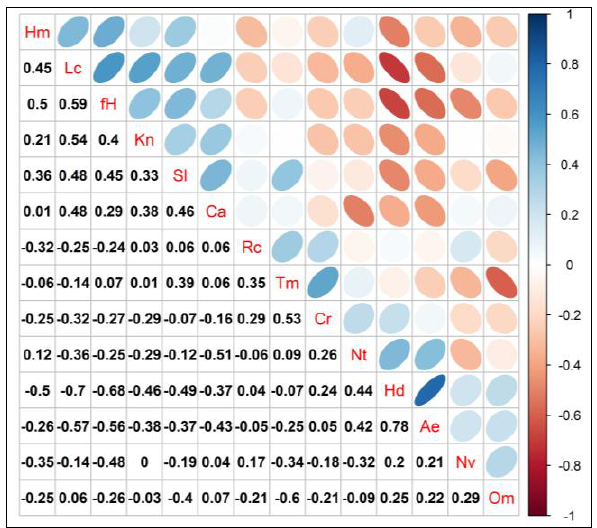
Fig. 2. Correlogram of environmental factors (according to phytoindicational assessment of the vegetation of afforestation belts syntaxa)